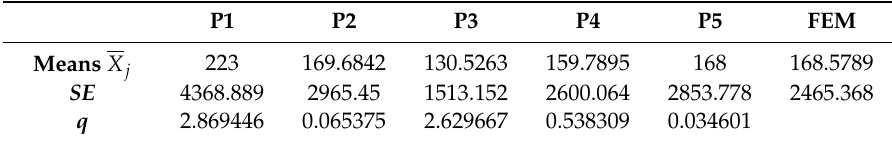
Table 4. The values calculated using Tukey’s test.